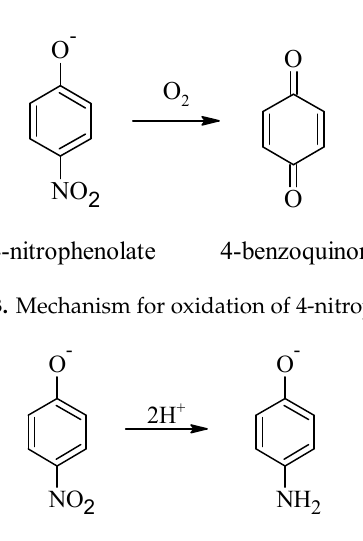
Figure S1: Electrochemical cell and Led driver kit used to performer photoelectrochemical characterization of BiVO 4 / CuO. (a) Electrochemical cell with quartz window, (b) Counter electrode (platinum foil), (c) Working electrode (FTO / BiVO 4 / CuO), (d) Reference electrode (Ag / AgCl, KCl 3 mol · L − 1 ), (e) Potentiostat, (f) Led driver, and (g) White led ( λ > 410 nm, 44 W); Figure S2: Tauc plots obtained from DRS data of (a) BiVO 4 , (b) BiVO 4 / CuO, and (c) CuO; Figure S3: Absorbance spectra of 4-nitrophenol obtained during their